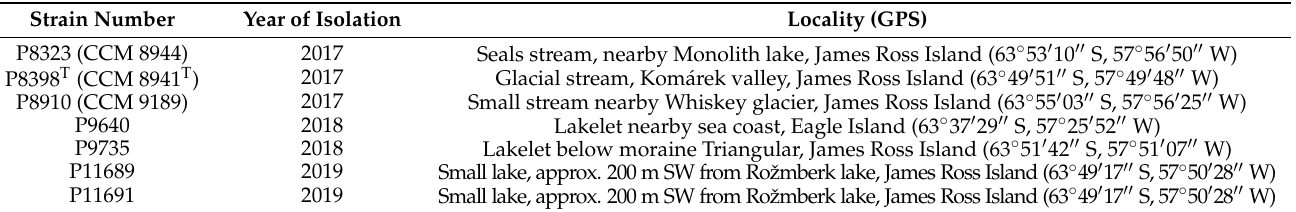
Table 1. Source of Massilia antarctica sp. nov.